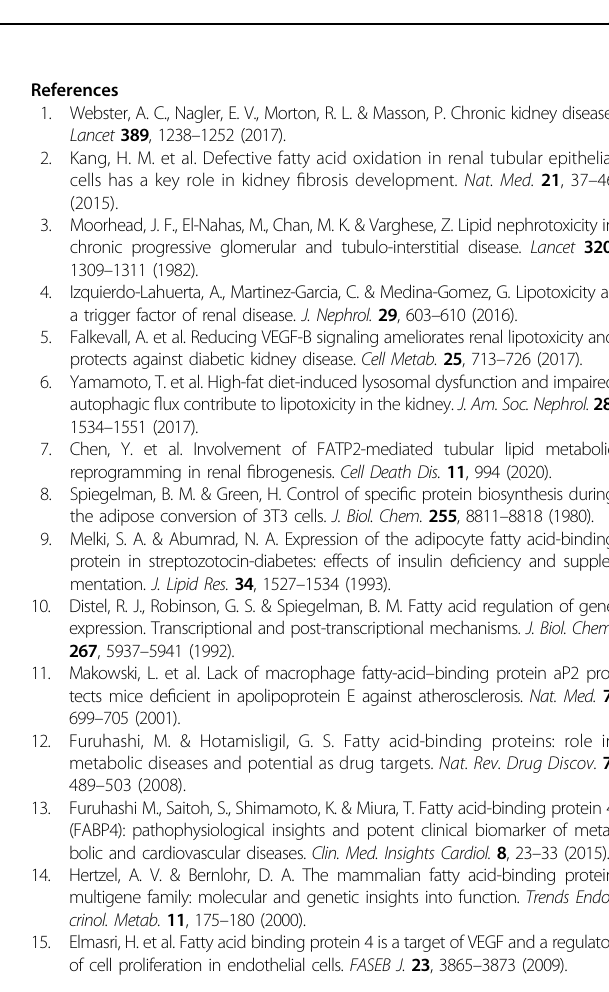
Fig. 8 Schematic diagram of the mechanisms of FABP4 in kidney fi brosis. BMS309403 reduces lipotoxicity to improve kidney fi brosis mainly by reducing lipid accumulation and increasing FAO pathway, and also reduce the secretion of a series of pro fi brotic cytokines by kidney TECs to relieve kidney fi